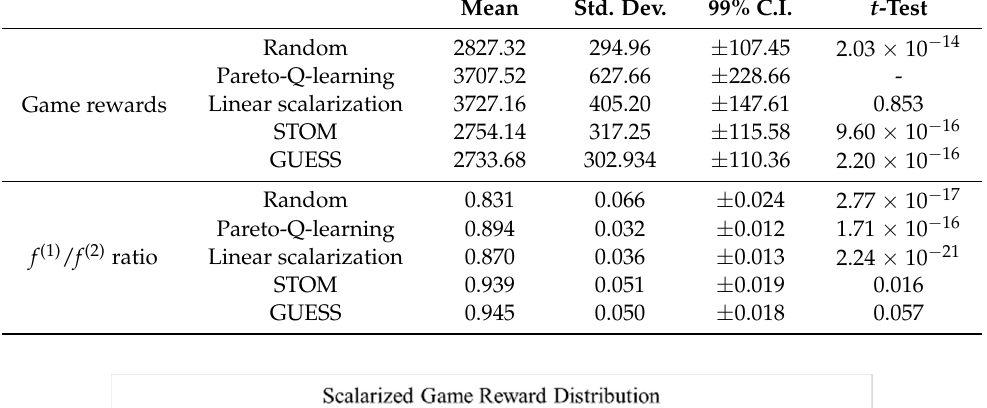
Table 2. Multiple game analysis results.